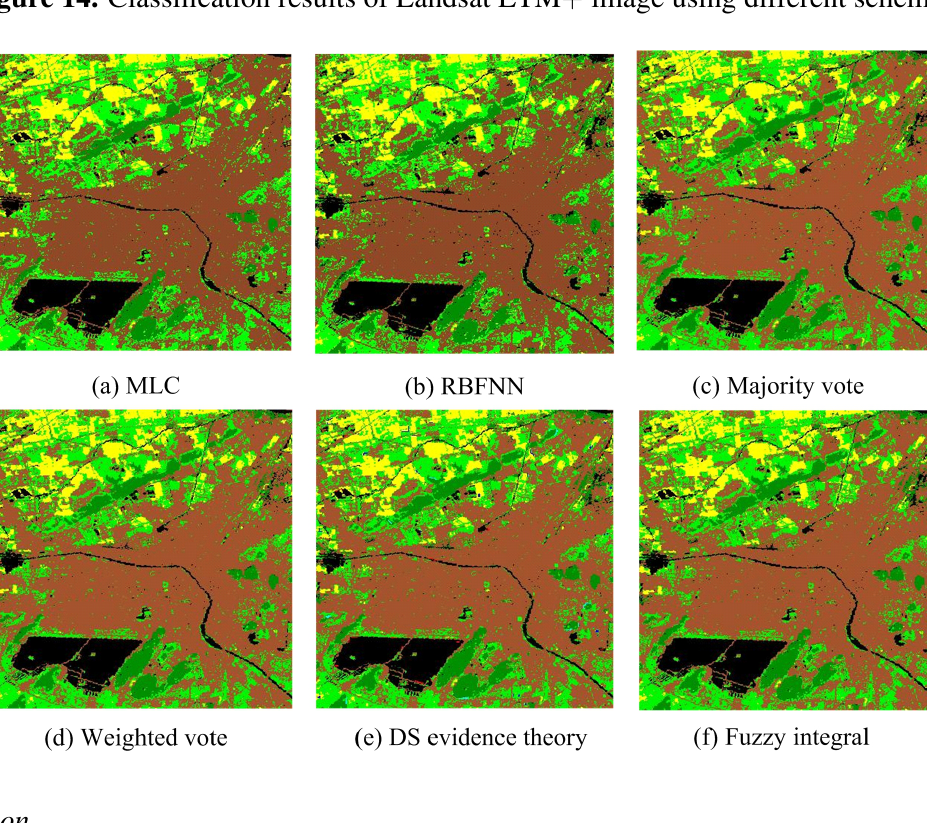
Figure 14. Classification results of Landsat ETM + image using different